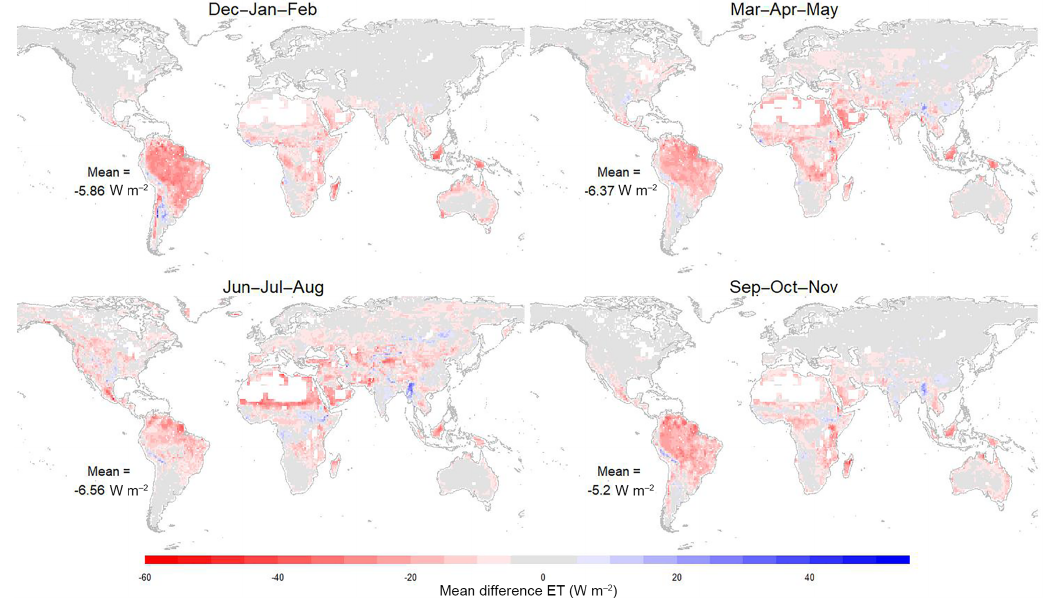
Figure 7. Difference between the seasonal average ET from LandFlux-EVAL-DIAG and DOLCE calculated over the period